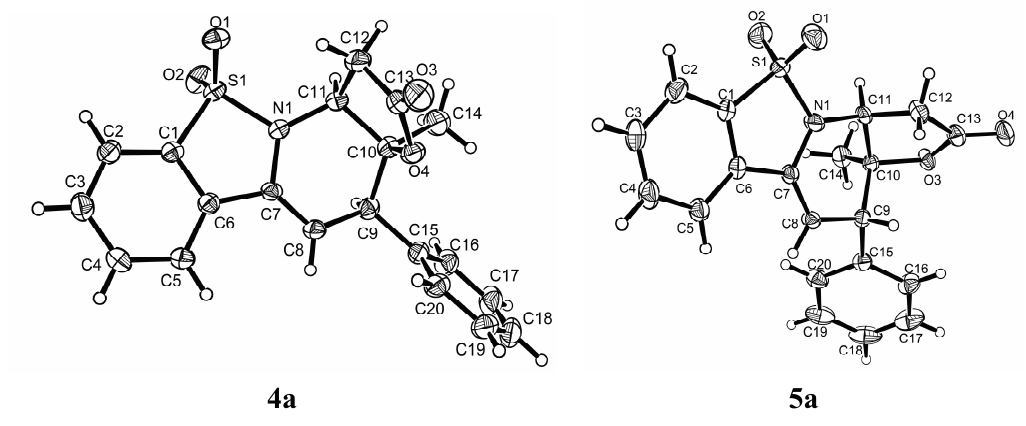
Figure 1. X-ray crystal structures of the cycloadducts 4a and 5a